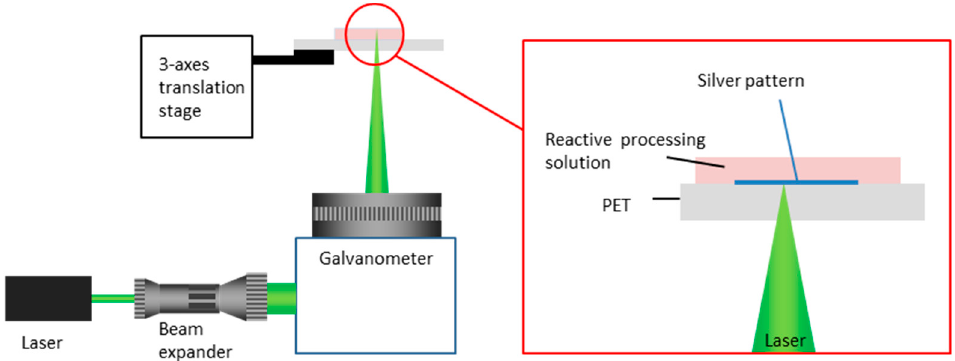
Figure 1. Experimental apparatus for the modified laser direct synthesis and pattering (LDSP) process.